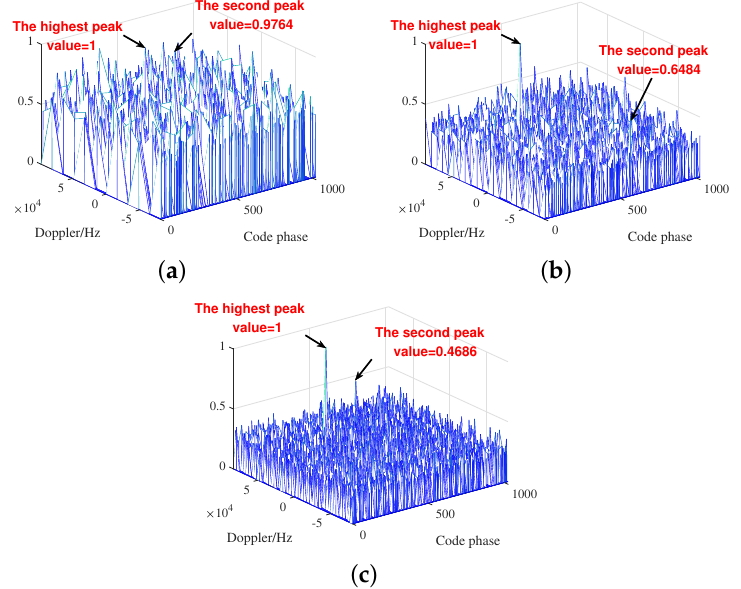
Figure 5. The acquisition results with different FCR : ( a ) FCR = 8:1; ( b ) FCR = 4:1; ( c ) FCR = 2:1.